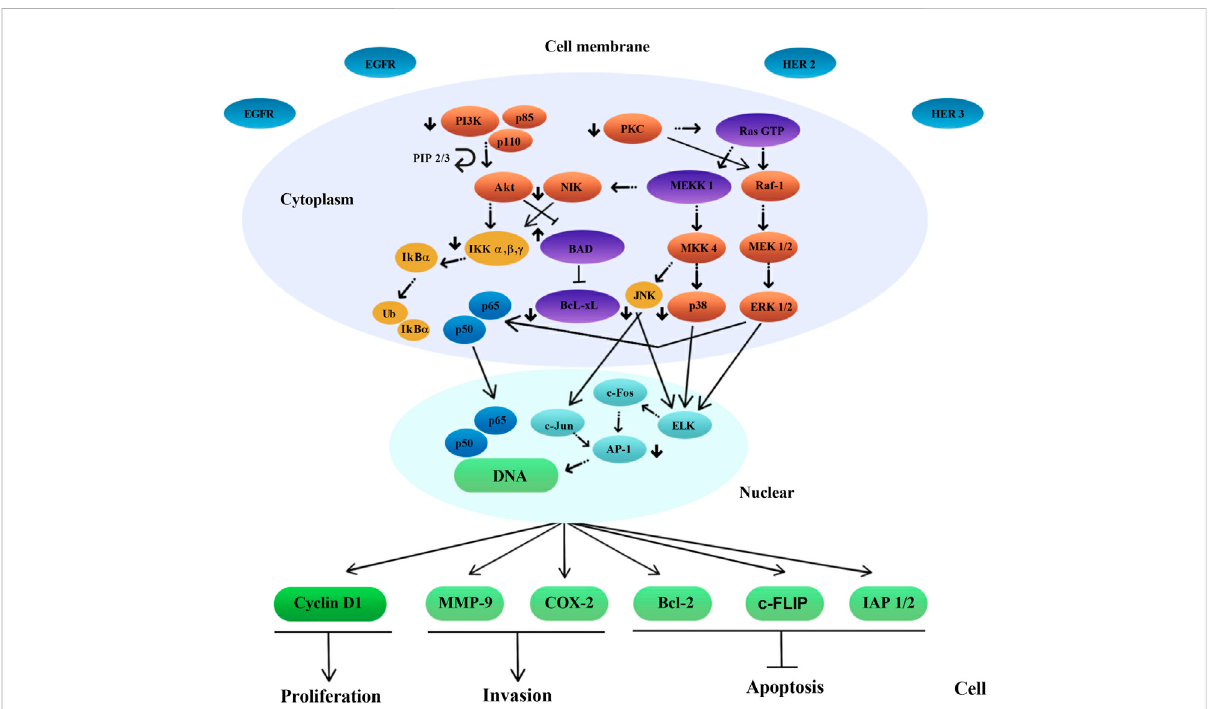
FIGURE 3 A scheme of intracellular signal transduction is presented. The inhibitory effect of epigallocatechin-3-gallate (EGCG) on some protein kinase signaling pathways and transcriptionfactors has been shown, as acomplex ofp65 and p50 subunits. Note: EGFR, Epidermal growth factor receptor; HER 2/3, Human epidermal growth factor receptor 2/3; PI3K, Phosphoinositide 3-kinases; PKC, Protein kinase C; Ras GTP, RAS guanosine triphosphate; NIK, NF-kappa-B-inducing kinase; MKK4, Mitogen-activated protein kinase kinase 4; MEK 1/2, Mitogen-activated protein kinase kinase 1/2; ERK 1/2, Extracellular signal-regulated kinase-1/2; JNK, c-Jun N-terminal Kinase; BAD, BCL2-associated agonist of cell death; PIP 2/3, Prolactin induced protein 2/3; Bcl-xL, B-cell lymphoma-extra large; IKK α , β , γ , Cytokine-responsive IkappaB kinase α , β , γ ; IkB α , Nuclear factor of kappalightpolypeptidegeneenhancerinB-cellsinhibitor,alpha;Ub,UbiquitinB;AP-1,Activatorprotein1;MMP-9,Matrixmetallopeptidase9;COX- 2, cyclooxygenase 2; Bcl-2, B-cell lymphoma-2; c-FLIP, Cellular FLICE-like inhibitory protein; IAP 1/2, Inhibitor of apoptosis